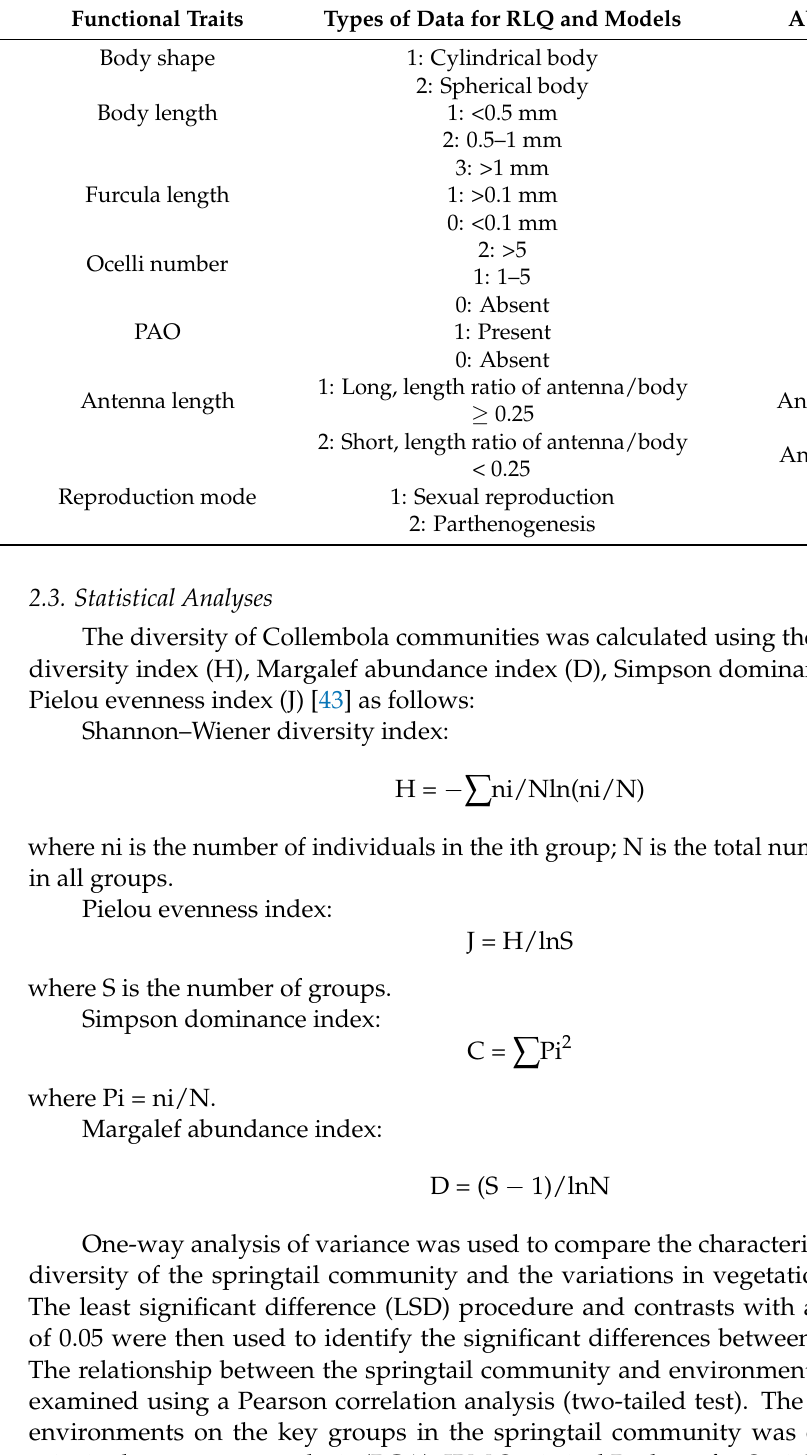
Table 2. Functional traits of